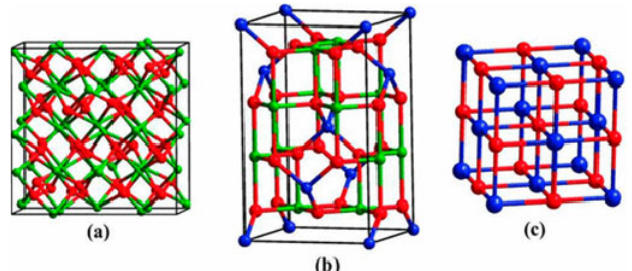
Figure 10. Crystal structures of mineral phases of (a) Mn 2 O 3 , (b) Mn 3 O 4 , and (c) MnO. All three manganese oxides are closely packed by lattice oxygen and differ only in the arrangement of octahedral and tetrahedral sites with various oxidation states of manganese. The green, blue, and red atoms represent Mn III , Mn II , and O 2 − , respectively. Reprinted and adapted with permission from Ref. [86]. Copyright 2014 John Wiley and Sons.